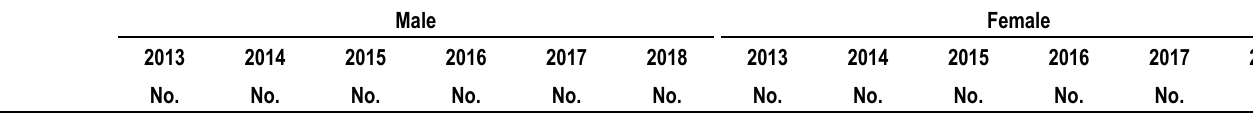
Table 9b. Diagnoses of HIV infection attributed to heterosexual contact, by selected characteristics, 2013–2018—United States and 6 dependent